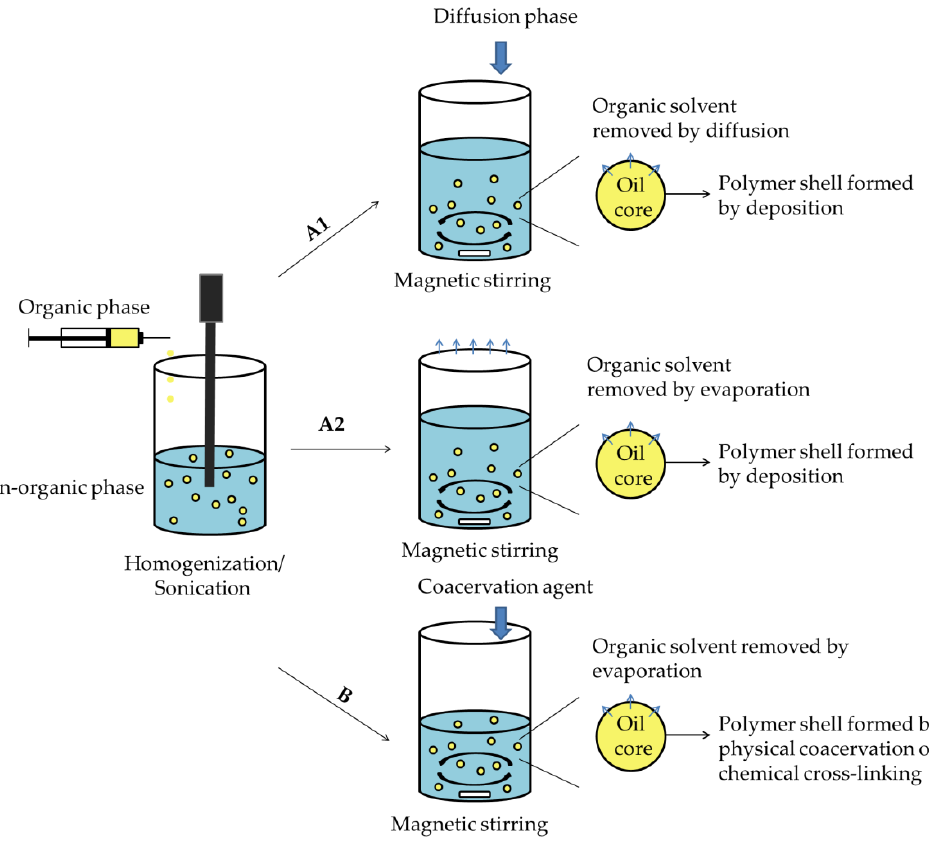
Figure 2. Schematic representation of nanocapsule formulation by nanoemulsion methods: A. Figure 2. Schematicrepresentationofnanocapsuleformulationbynanoemulsionmethods: ( A ).nanoemulsion– di ff usion / evaporation method; ( B ). nanoemulsion–coacervation